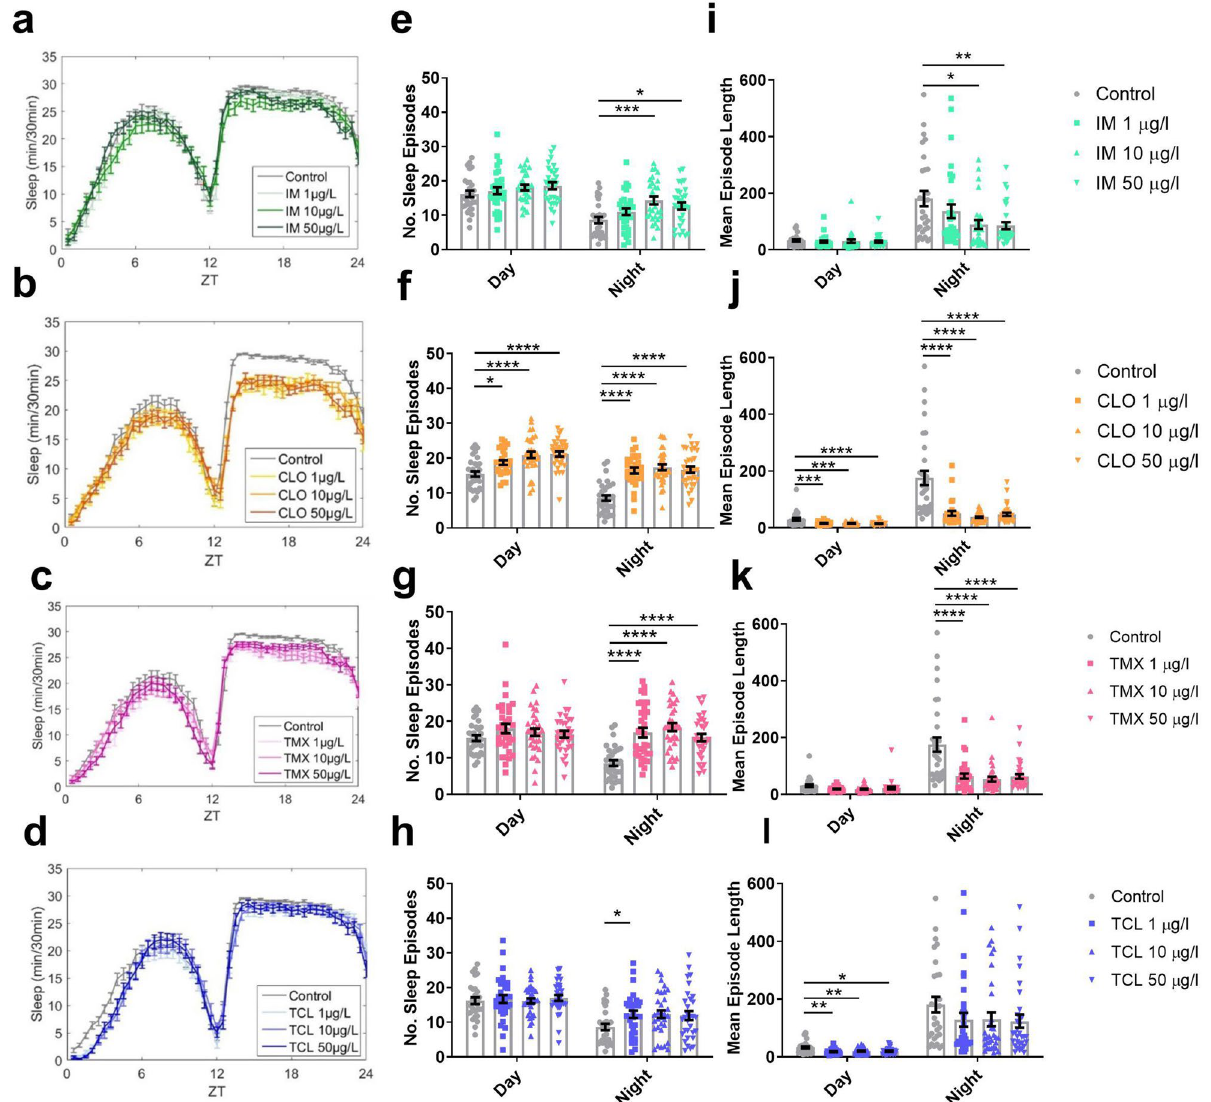
Figure 3. Field relevant concentrations of neonicotinoids disrupted sleep behaviour. Sleep plots showing the total sleep achieved per 30 min bin over the 24 h period (zeitgeber time (ZT)) for flies exposed to 1, 10 or 50 µg/L of ( a ) imidacloprid, ( b ) clothianidin, ( c ) thiamethoxam or ( d ) thiacloprid. The number of (no.) of sleep episodes initiated in ( e ) IM, day ( F 3,114 = 1.2, p = 0.320) and night ( F 3,114 = 5.5, p = 0.001), ( f ) CLO, day ( F 3,120 = 11.5, p < 0.001) and night ( F 3,120 = 25.0, p < 0.001), ( g ) TMX, day ( F 3,124 = 1.1, p = 0.344) and night ( F 3,124 = 17.0, p < 0.001) or ( h ) TCL, day ( F 3,120 = 0.2, p = 0.872) and night ( F 3,120 = 3.0, p = 0.034). Mean length (in minutes) of sleep episodes initiated in ( i ) IM, day ( F 3,114 = 0.2, p = 0.889) and night ( F 3,114 = 4.5, p = 0.005), ( j ) CLO, day ( F 3,120 = 9.9, p < 0.001) and night ( F 3,120 = 21.8, p < 0.001), ( k ) TMX, day ( F 3,124 = 2.5, p = 0.061) and night ( F 3,124 = 15.7, p < 0.001) or ( l ) TCL, day ( F 3,120 = 5.2, p = 0.002) and night ( F 3,120 = 2.0, p = 0.121). Each data point represents a single fly, n = 28–32 flies per treatment. CLO and TMX were run together with one set of controls, whilst IM and TCL were run together with another control